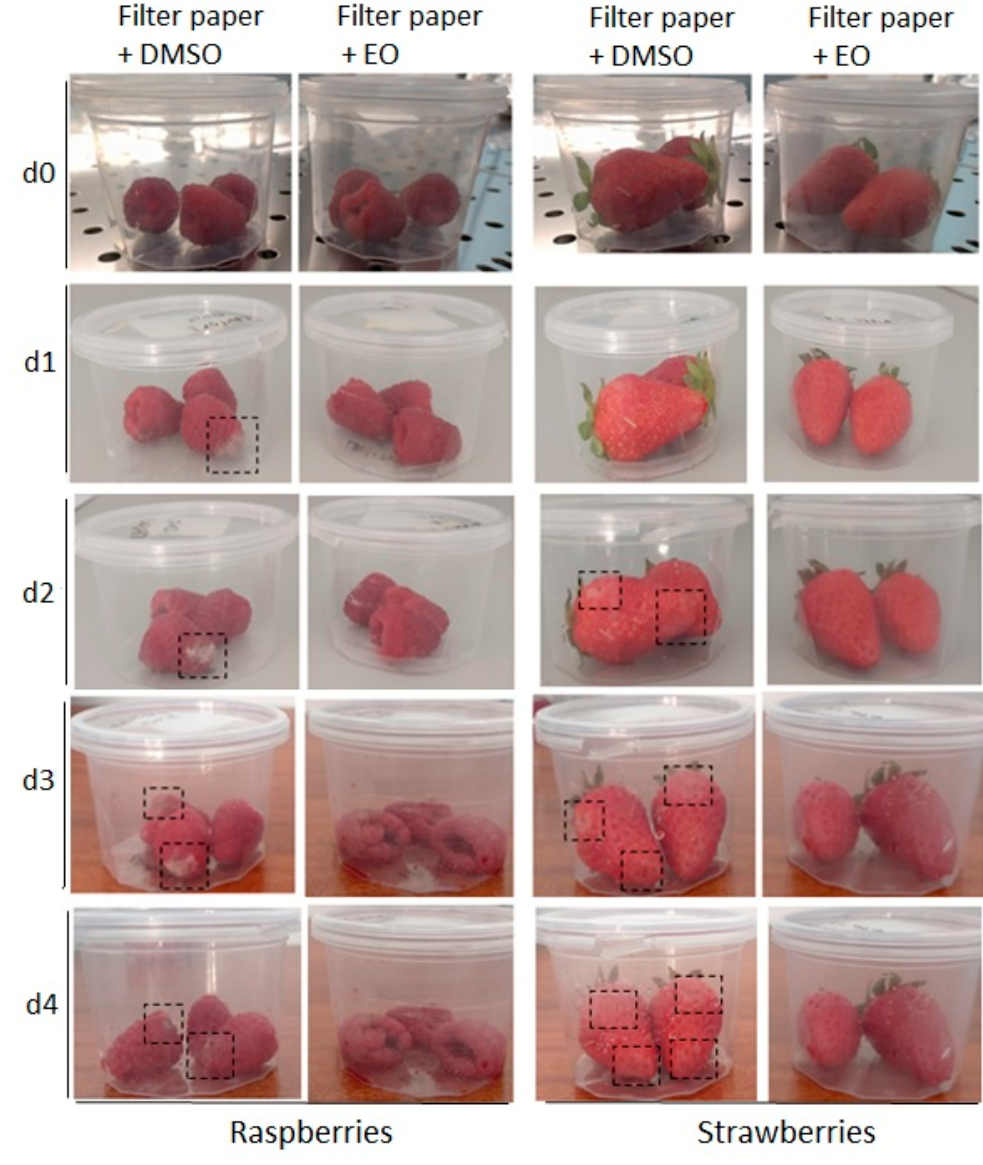
Figure 5. Raspberries and strawberries were incubated by sterile filter paper with 10% ( v / v ) cinnamon oil for four days ( d0 – d4 ) at room temperature. Sterile filter paper covered with 10% DMSO in PBS solution was used in the control sample.